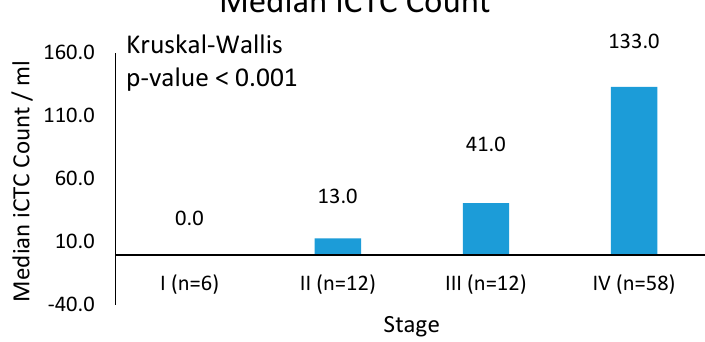
Figure 2. iCTC detection rate by disease stage. Percentage of patients within each stage group and their detectable iCTC rates. iCTC detection varied considerably between Stage III/IV disease and Stage I/II disease ( p -value < 0.001).